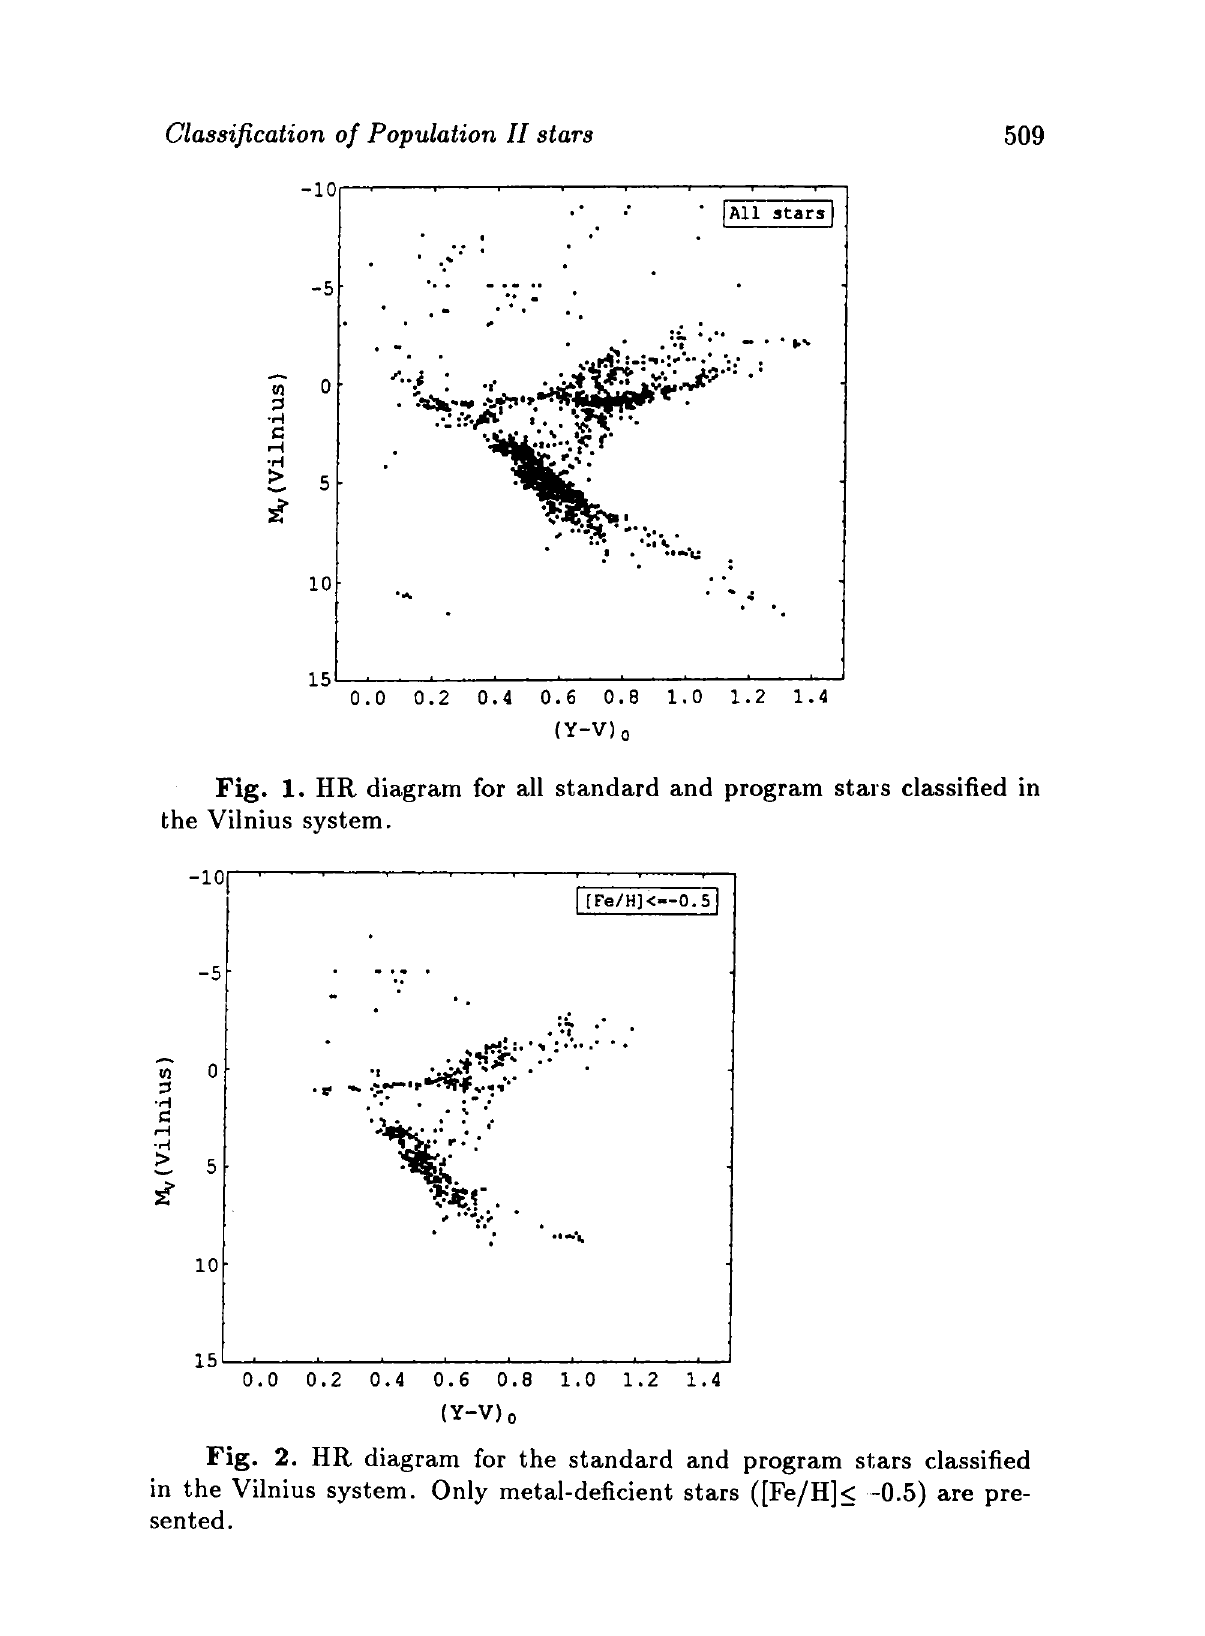
Fig. 2. HR diagram for the standard and program stars classified in the Vilnius system. Only metal-deficient stars ([Fe/H]< -0.5) are pre-